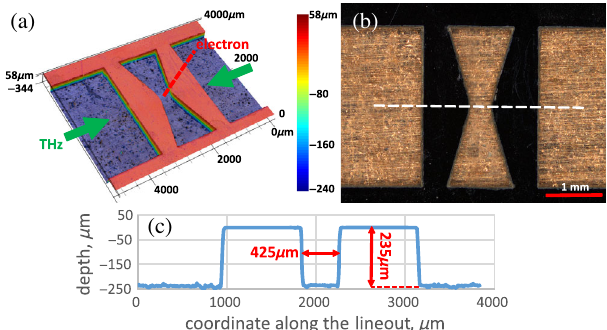
FIG. 13. (a) 3D scanning microscope metrology of the fabri- cated structure. THz input and electron trajectory are schemati- cally shown. (b) Optical image of the structure with depth profile lineout shown. (c) Depth profile along the lineout from